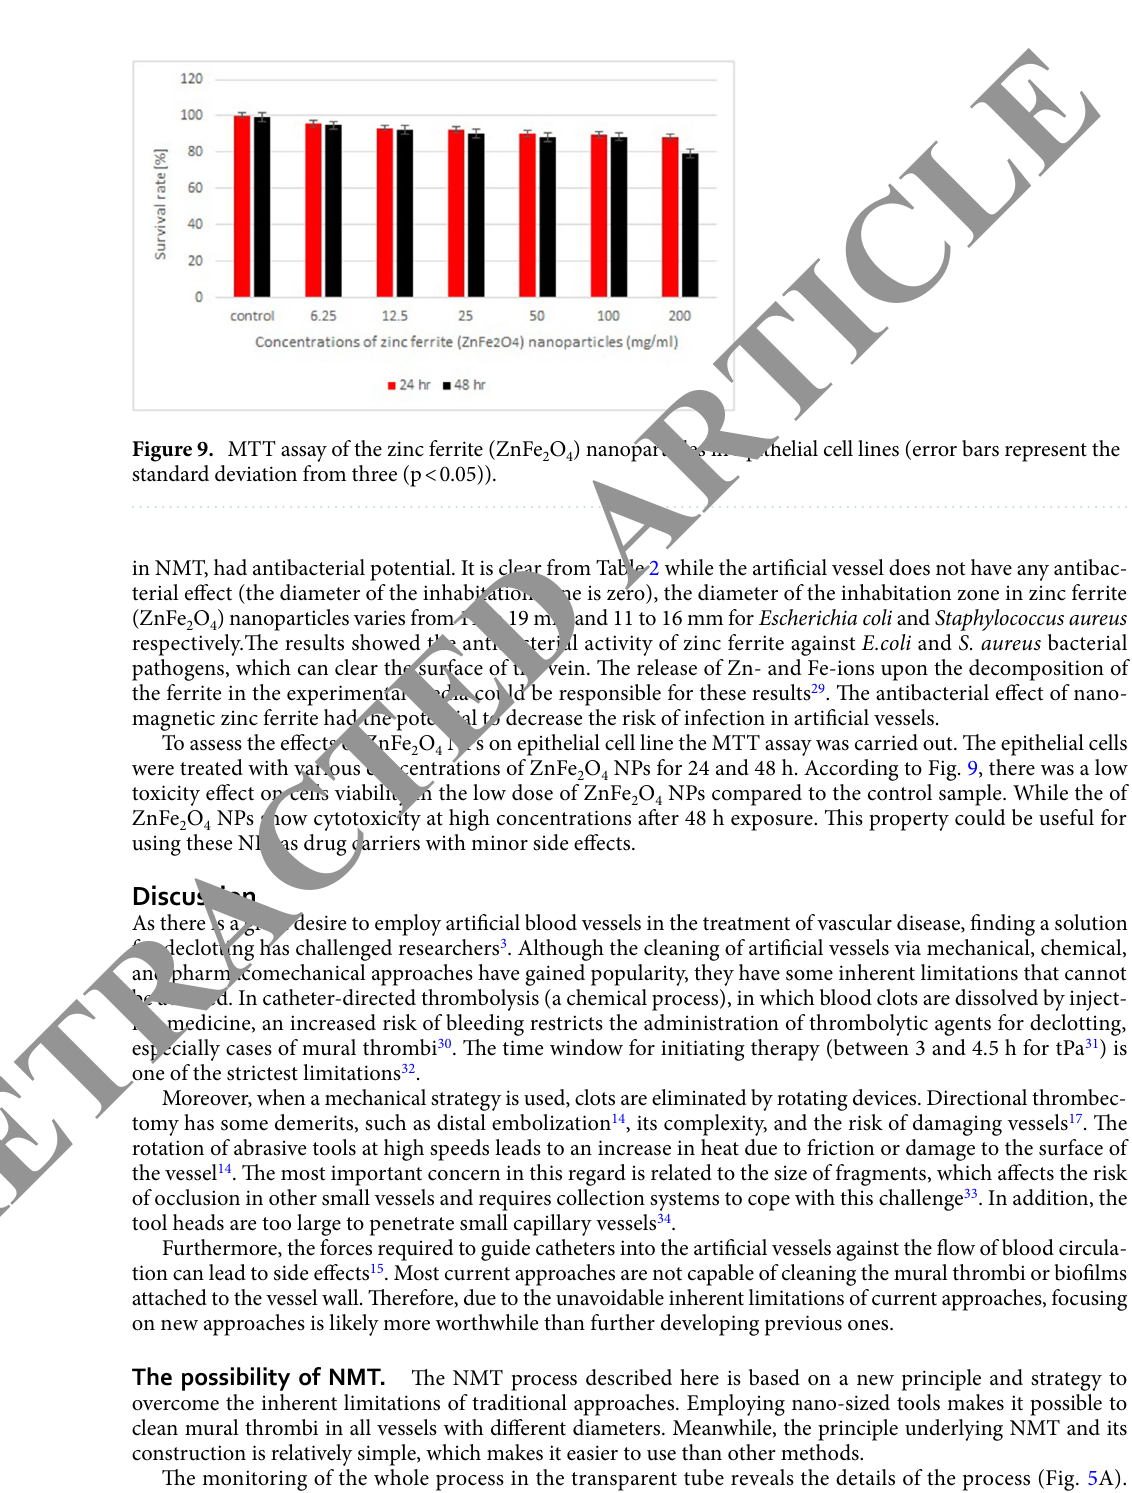
Table 2. Antibacterial activity of zinc ferrite (ZnFe 2 O 4 ) nanoparticles by Zone of Inhibition